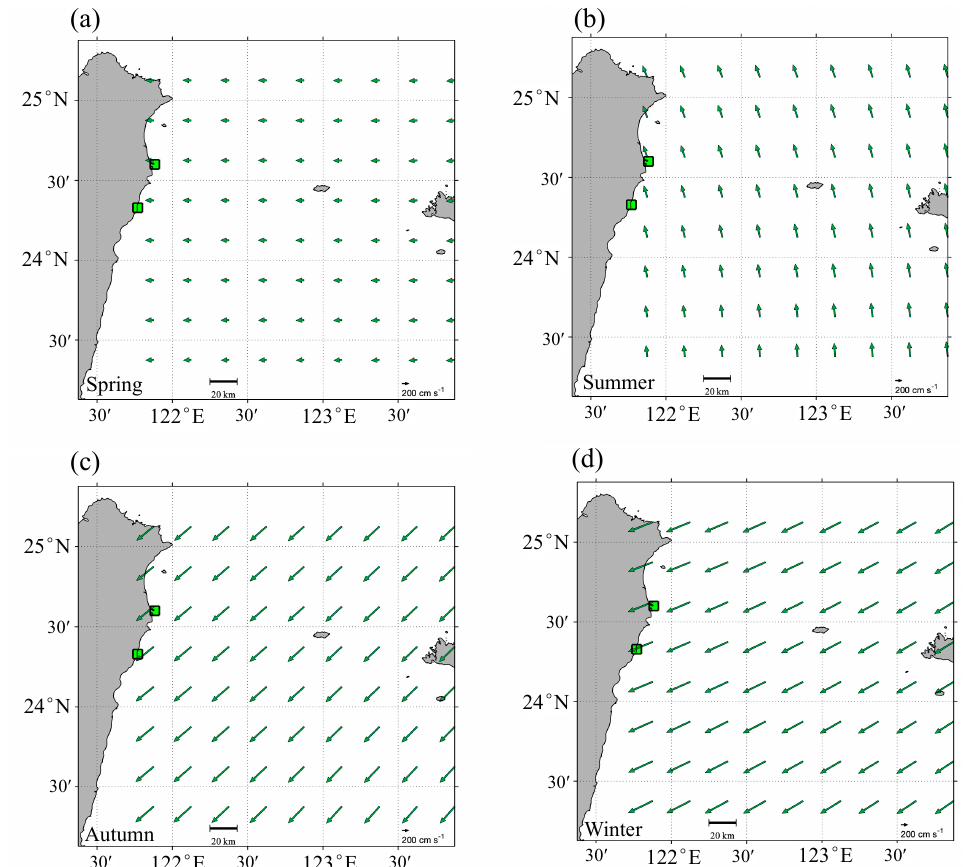
Figure 4. Wind fields for the four seasons off eastern Taiwan. The wind direction reverses between winter and summer, whereas the wind is basically from the northeast in winter and autumn. ( a ) Spring, ( b ) Summer, ( c ) Autumn, and ( d ) Winter .